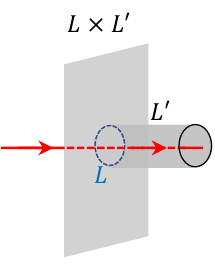
Figure 4 . The red operator pierces the codimension-one symmetry defect L (cid:2) L 0 where L supports the symmetry defect not local with respect to the red operator. Then by shrinking the circumference of the cylinder we (cid:12)nd the red operator leaves the codimension-one symmetry defect with (a power of) additional symmetry defect L 0 attached to